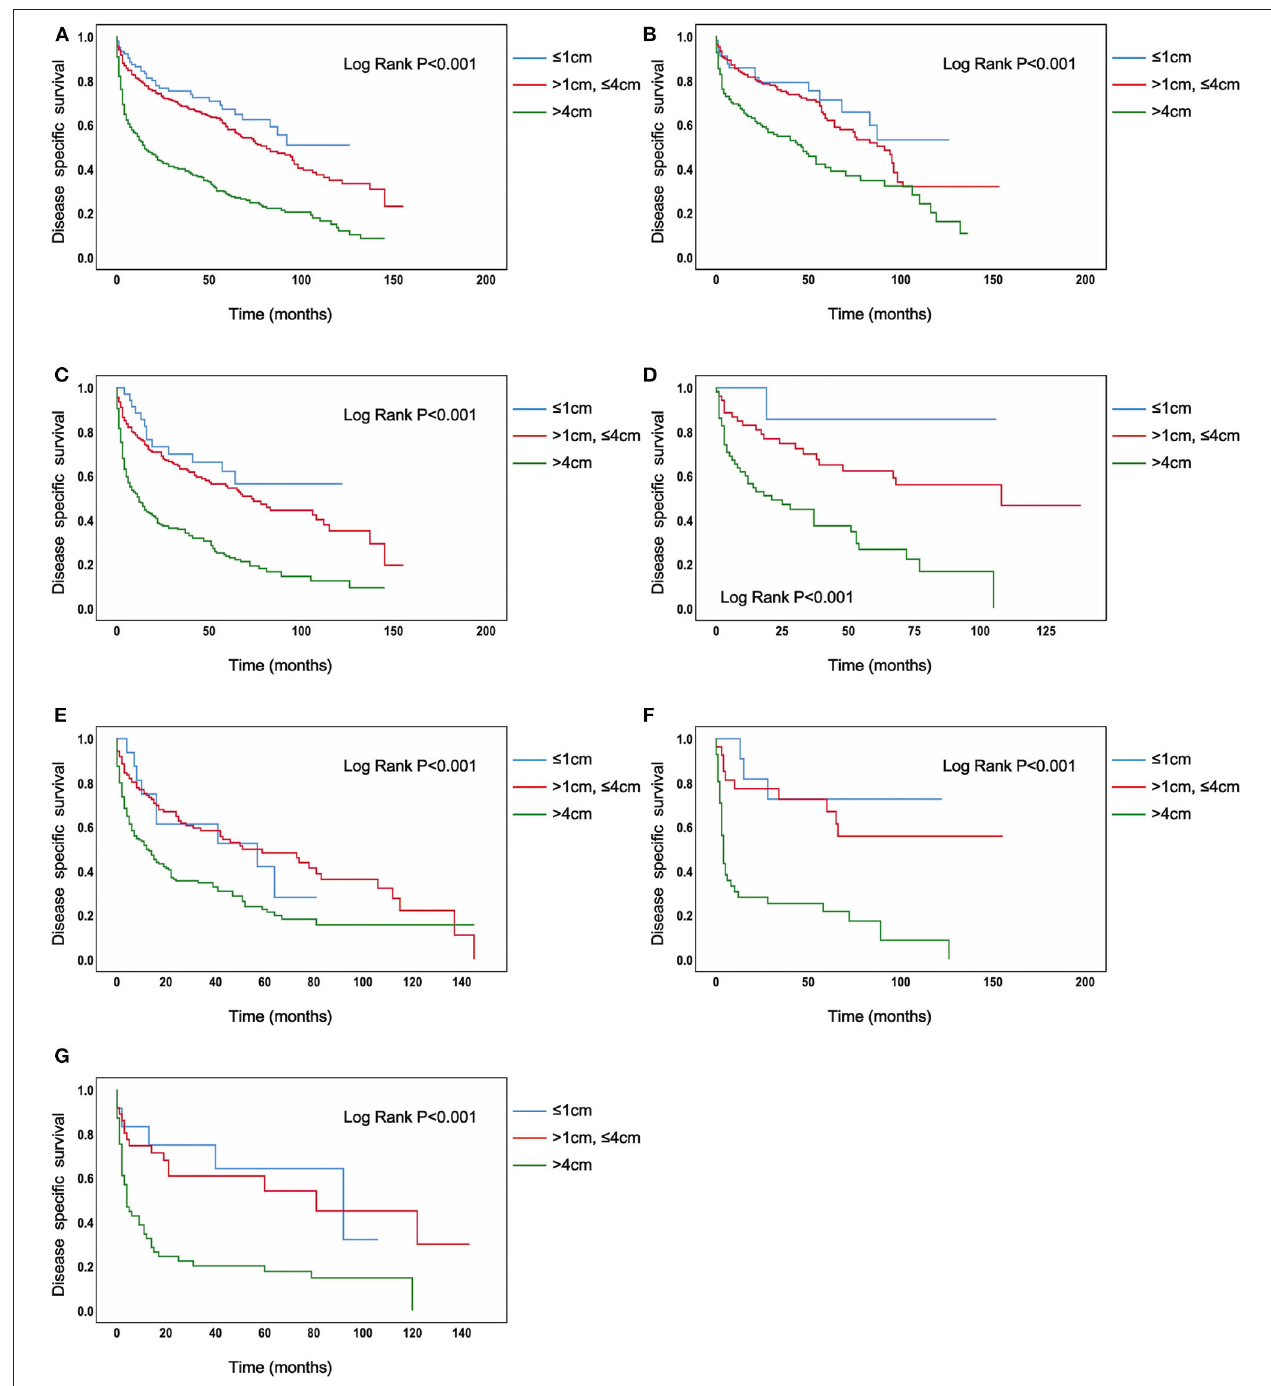
FIGURE 1 | Disease specific survival of thyroid cancer patients with IVB stage stratified by tumor size using Kaplan–Meier analysis and log-rank tests. (A) All thyroid cancer patients. (B) Thyroid cancer patients with N0 category. (C) Thyroid cancer patients with N1 category. (D) Thyroid cancer patients with N1A category. (E) Thyroid cancer patients with N1B category. (F) Thyroid cancer patients with N1NOS category. (G) Thyroid cancer patients with Nx category. (All Log Rank P < 0.001).